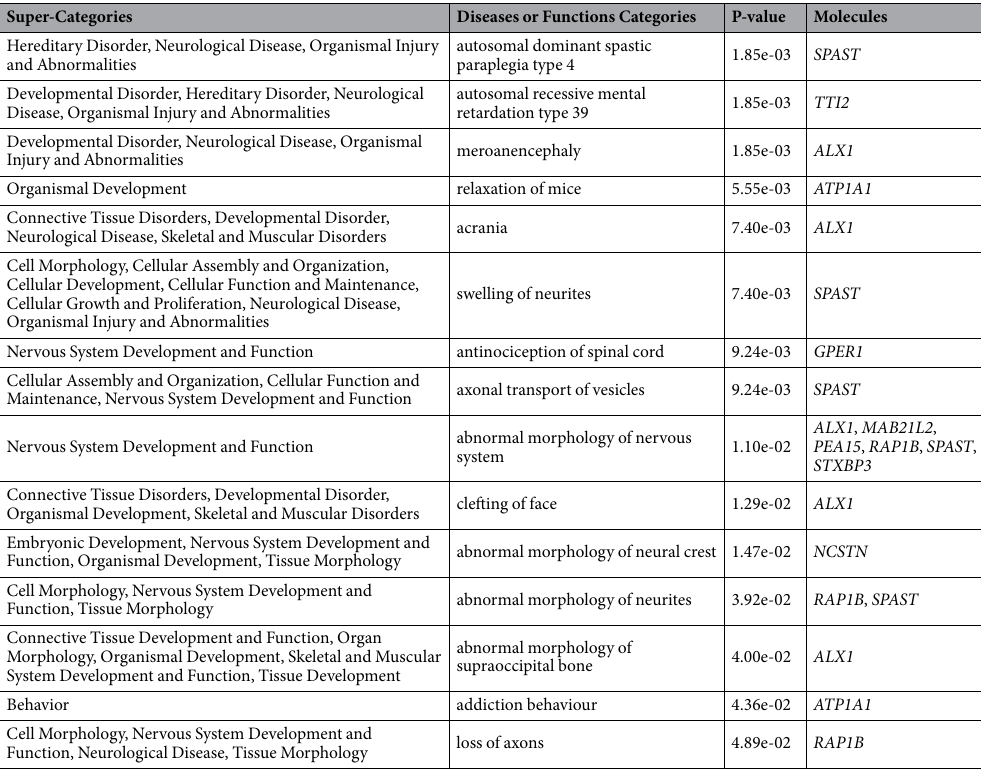
Table 3. Significant nervous system-related categories identified in the disease and functional enrichment analyses using IPA software, considering 40 genes identified in the gene-wide analyses surpassing follow-up significance threshold (P-value < 1e-03).